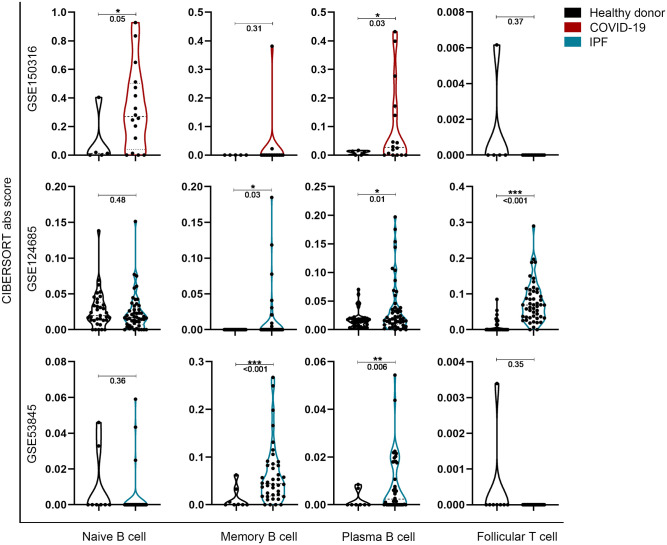
In silico simulated B-cell lineage infiltration in lung tissue between COVID-19 and IPF patients.*P<0.05, **P<0.01 and ***P<0.001, with comparisons indicated by brackets.